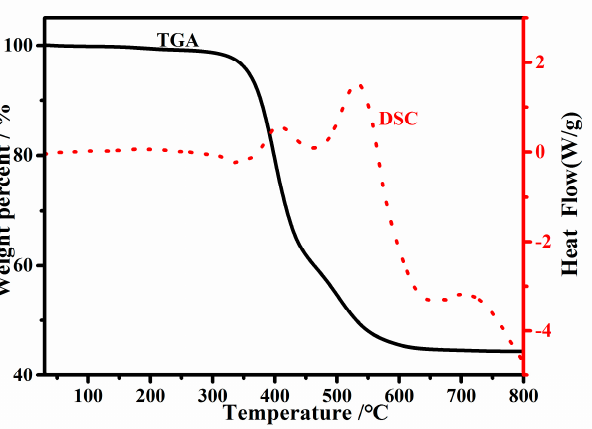
Figure 9. Differential scanning calorimetry (DSC) and thermogravimetric analysis (TGA) curves of EP-POSS.